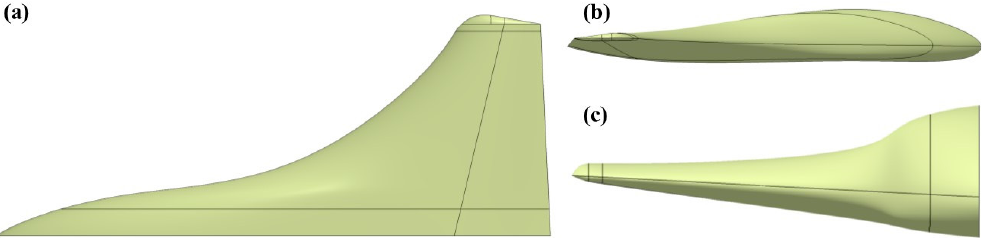
Figure 4. Three-dimensional aerodynamic shape of the hypersonic vehicle. ( a ) Top view; ( b ) Side view; ( c ) Front view. Table 1. Initial values of the independent parameters.